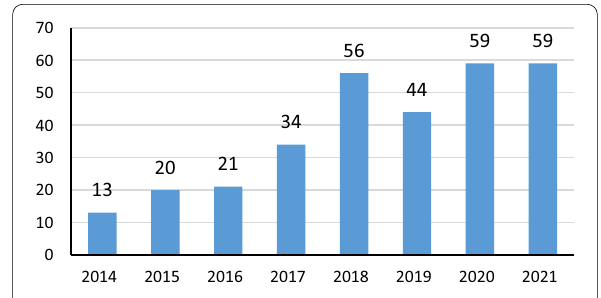
Fig. 1 Number of publications by year (Source: Journal website)